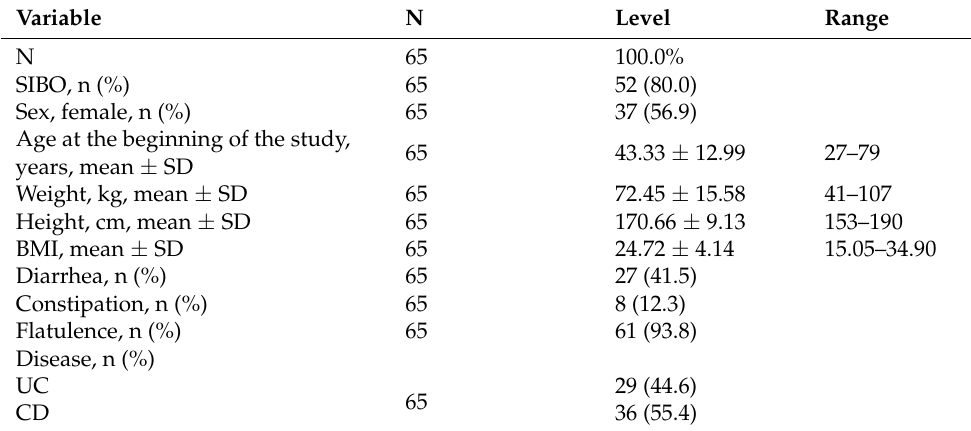
Table 1. Baseline characteristics of IBS